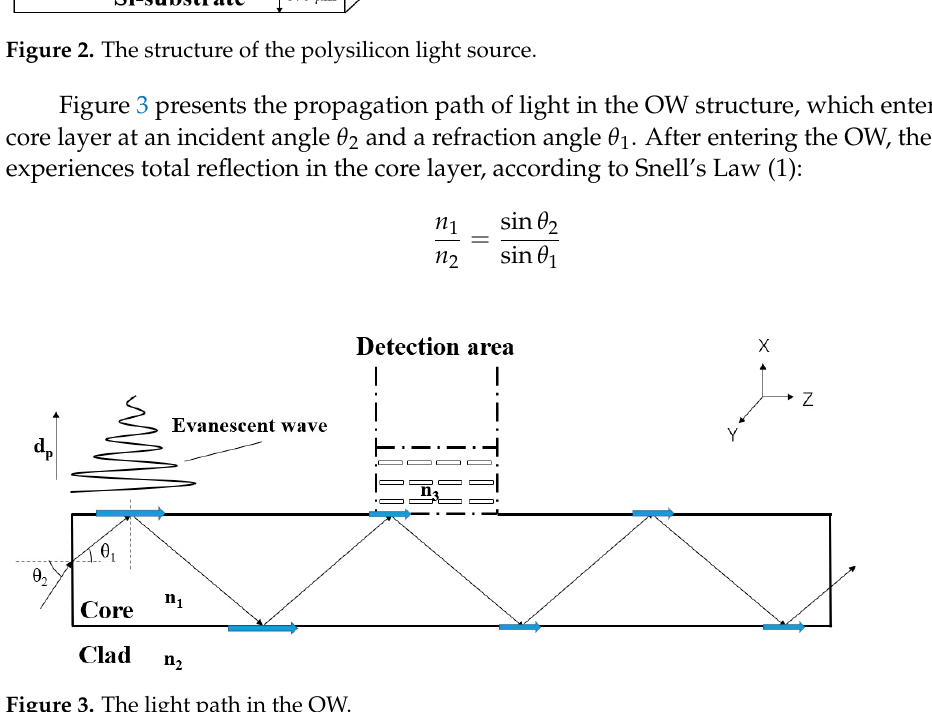
Figure 3. The light path in the OW.